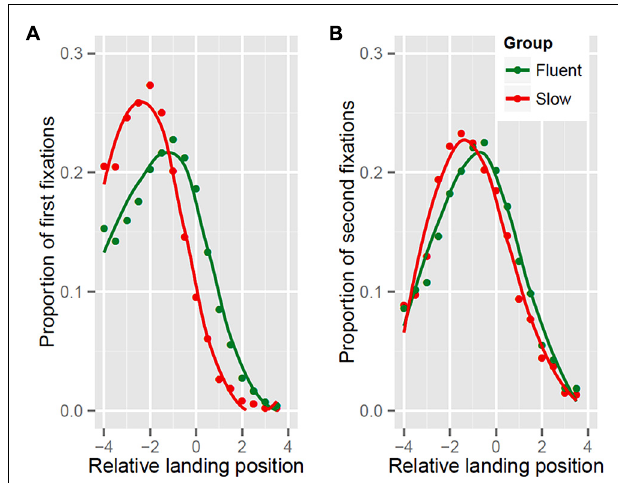
FIGURE 2 | Landing position distributions of the initial (A) and second fixation position (B) for slow and fluent readers. The initial landing position is presented in relation to the center of the